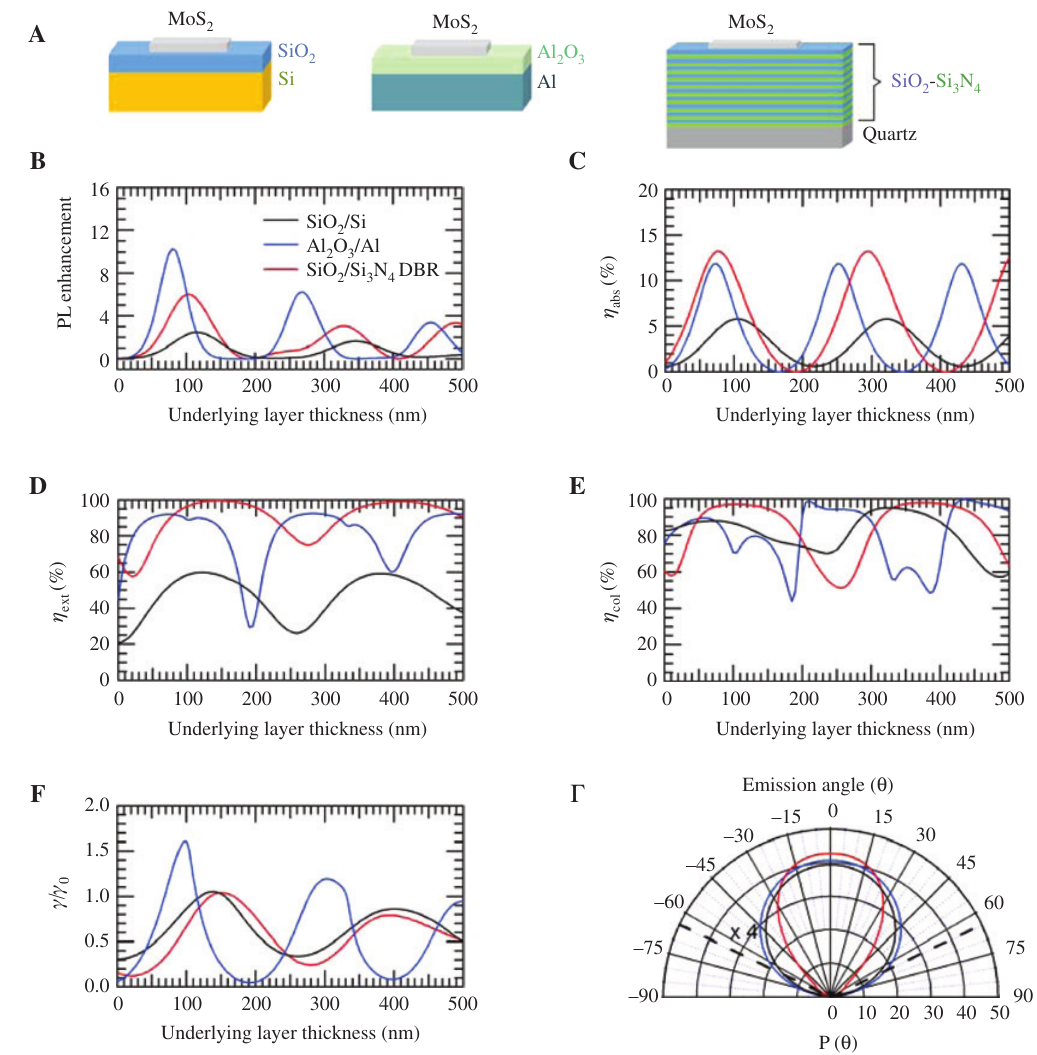
SL. (B) Cal- 2 layer 2